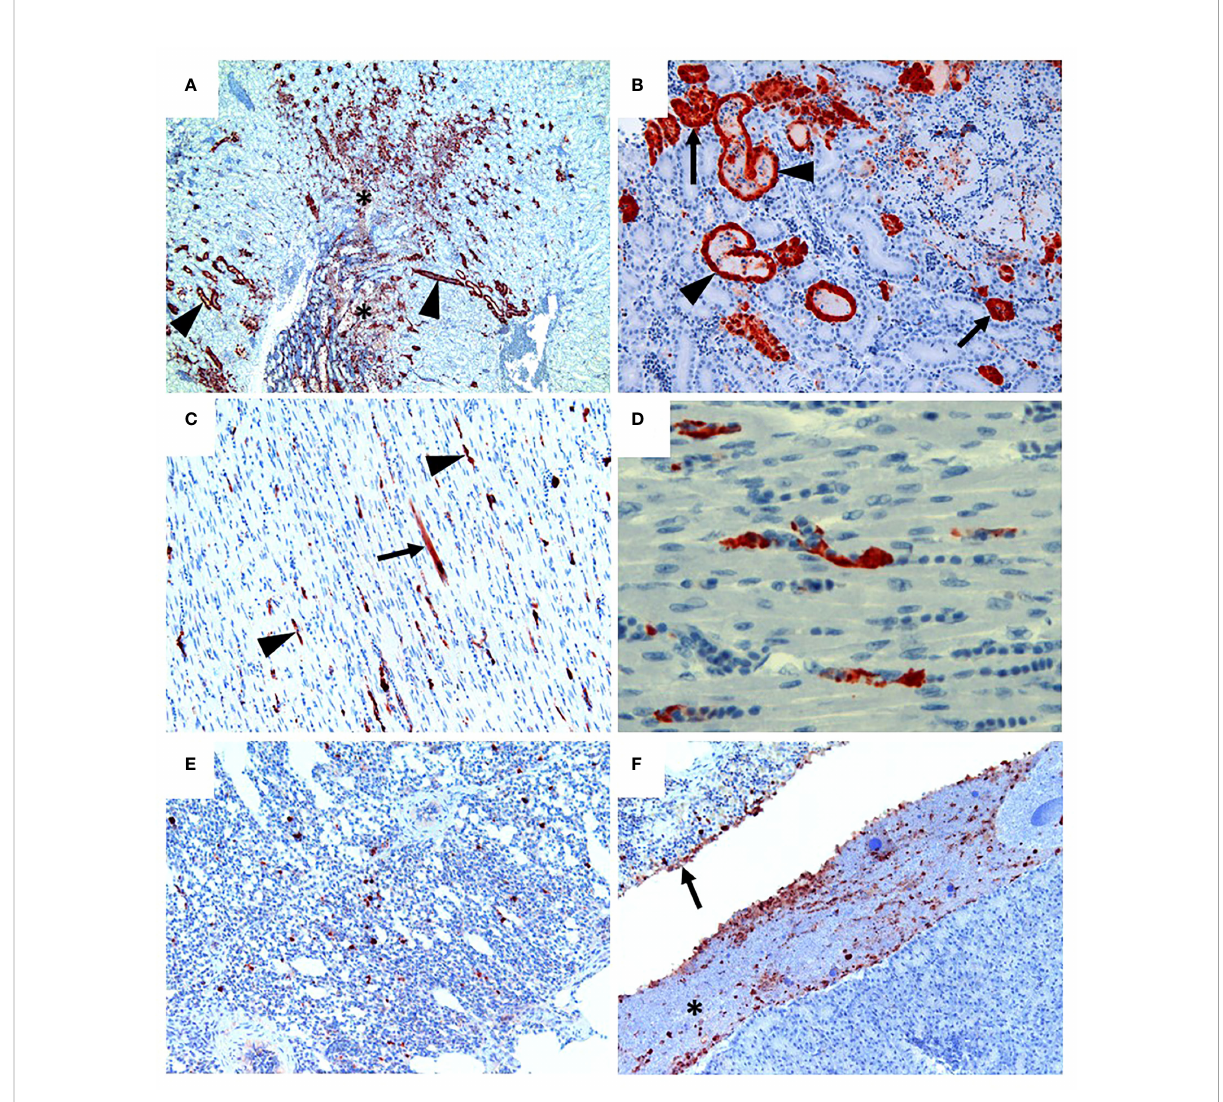
FIGURE 2 H7N9 avian in fl uenza viral localisation in tissues of 16 week-old chickens inoculated via the ONO route. (A) Kidney (Chicken 11), showing viral antigen in renal tubules (arrowheads). Viral infection is also associated in some regions with localised necrosis of renal interstitium and tubules (*). (B) Kidney (Chicken 11), higher magni fi cation of the same tissue, showing viral antigen in the epithelium of the tubules. While some tubules appear healthy (arrows), others are distended with necrotic material (arrowheads). (C) Heart (Chicken 11), showing that viral antigen is mainly within capillary endothelium (arrowheads) and in one cardiomyocyte (arrow). (D) Heart (Chicken 11), higher magni fi cation of the same tissue, showing detail of viral antigen in capillaries. Enucleated erythrocytes can be seen lined up within some of the capillaries. (E) Lung (Chicken 5), showing viral antigen within single cells, presumed to be macrophages, within the lung parenchyma. (F) Viral antigen is present in the yolk material (*) and in fl ammatory exudate within the airsac overlying the pancreas (bottom right of the image) and in the airsac membrane overlying the in fl amed serosal surface of the duodenum (arrow) (Chicken 11). Immunohistochemistry for in fl uenza nucleoprotein (red-brown pigment), counterstained with